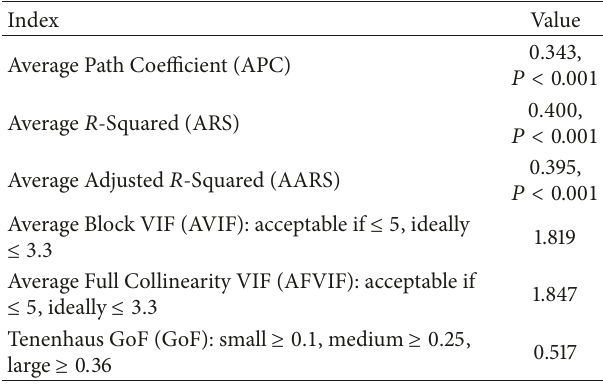
Table 4: Model fit and quality